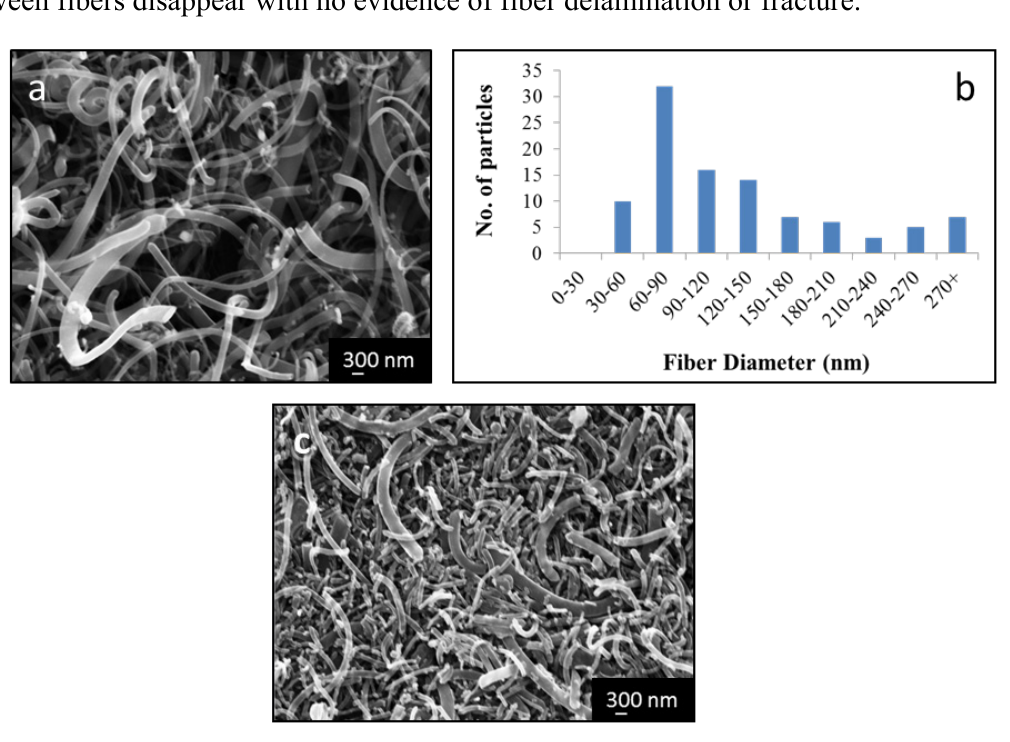
Figure 1. Microstructural analysis by SEM. ( a ) The sample consists of fibers which diameters vary between 30 and 400 nm and regions of empty space; ( b ) The plurality of fibers are between 60 and 90 nm in width; ( c ) During compression the empty spaces between fibers disappear with no evidence of fiber delamination or